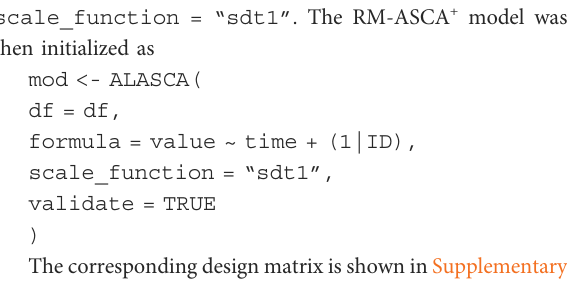
RM-ASCA + extracted two general patterns of change as represented by the fi rst (PC1) and second (PC2) principal component, explaining 87% and 9%, respectively, of the variability in the data set (Supplementary Figure S2). Each component is associated with positive and negative loadings describing how each plasma protein is related to the corresponding PC. Proteins with positive loadings have higher concentration in time points with higher score values, and vice versa for proteins with negative loading values.